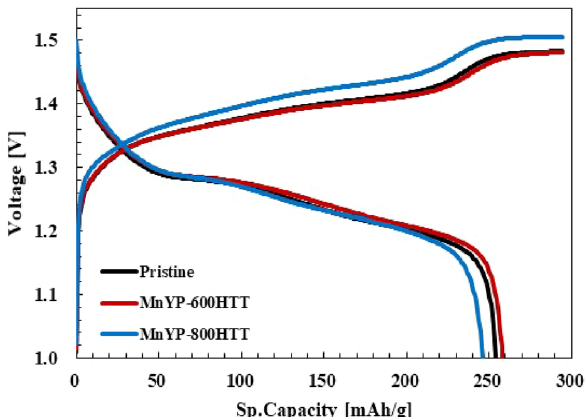
Figure 9. The charge–discharge profiles of Pristine, Mn-doped MnYP-600HTT and MnYP-800HTT after 10 cycles.